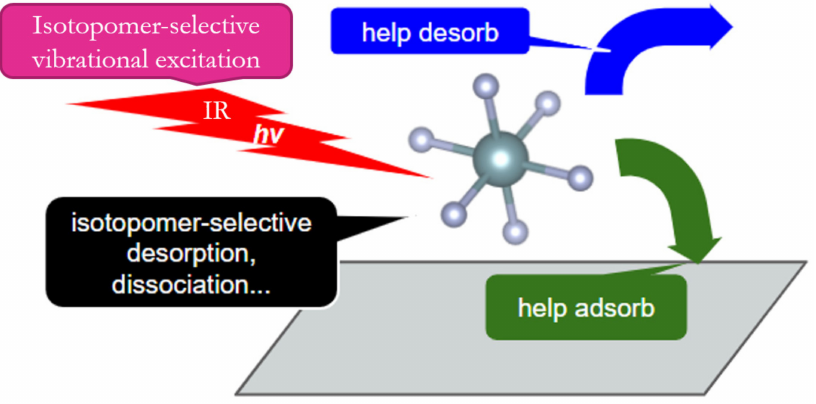
Figure 6. Principle of IR laser-driven isotopomer-selective desorption of UF 6 proposed in [129].